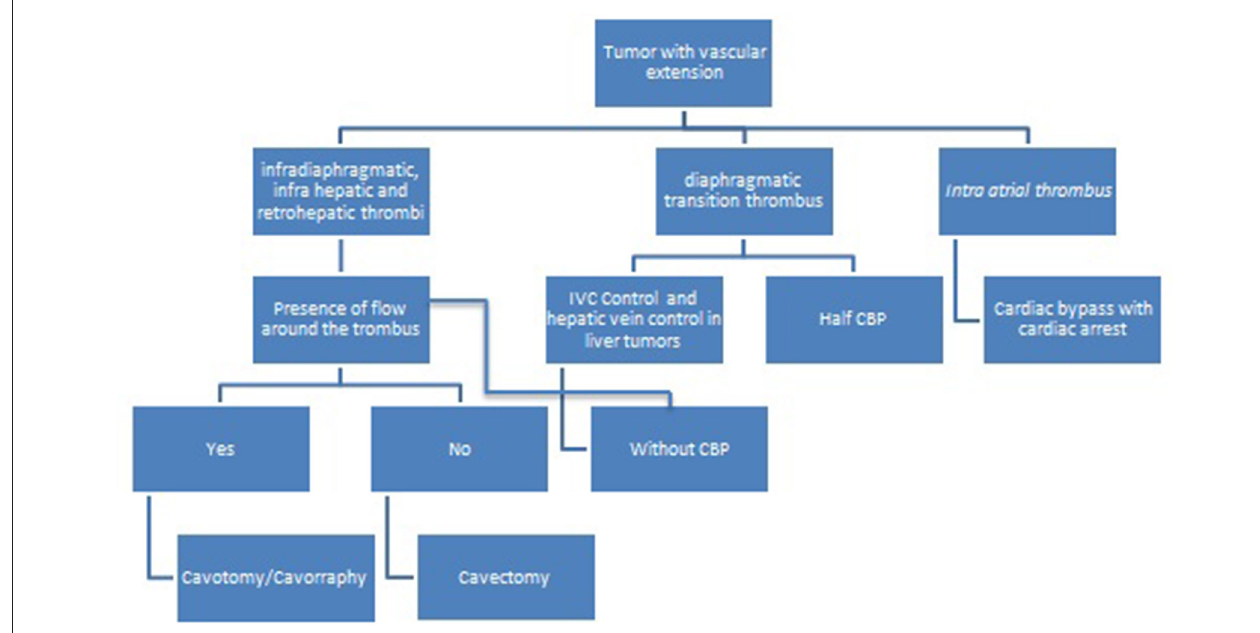
FIGURE 1 | Decision-making fluxogram for surgical treatment of pediatric tumors with vascular